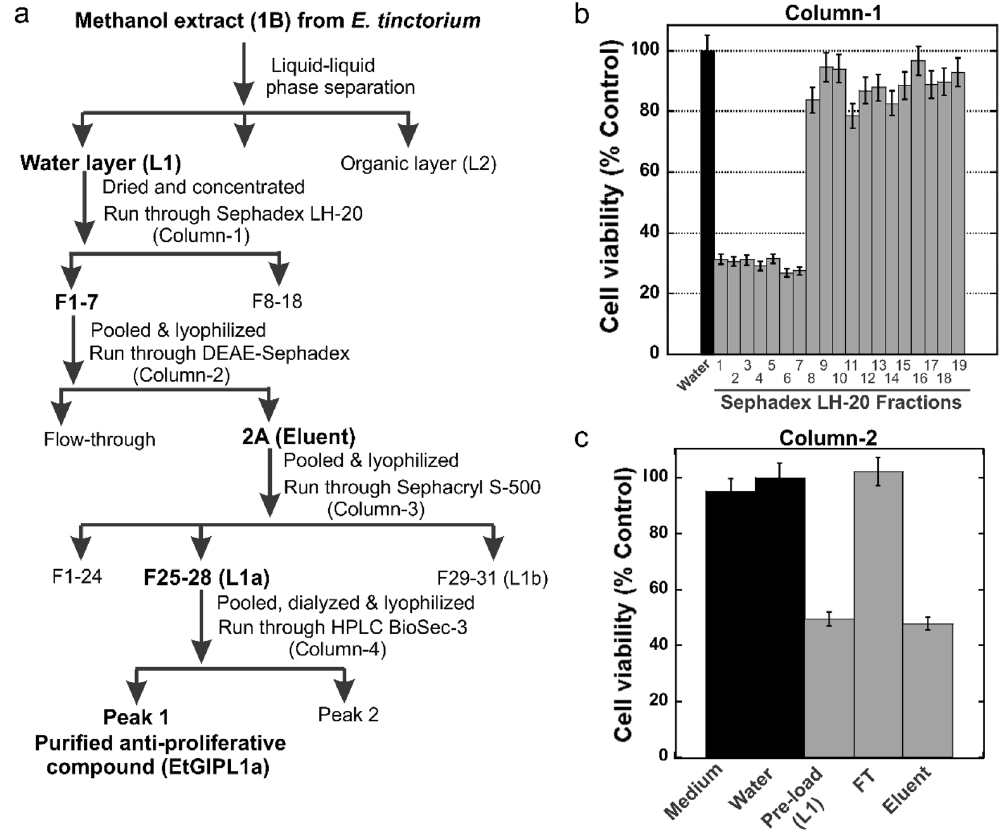
Figure 1. Purification of the anti-proliferative polysaccharide (EtGIPL1a) from E. tinctorium . ( a ) Summary of the purification scheme used. ( b ) 1B extract from E. tinctorium was purified using Sephadex LH-20 size- exclusion chromatography (column-1). Active fractions (F1-7) were pooled, lyophilized and ran through DEAE-Sephadex anion exchange chromatography (column-2) as shown in ( c ). The eluent (2A) showed anti- proliferative activity while the flow-through (FT) had no activity. Error bars represent S.D. Results shown are representative from three biological